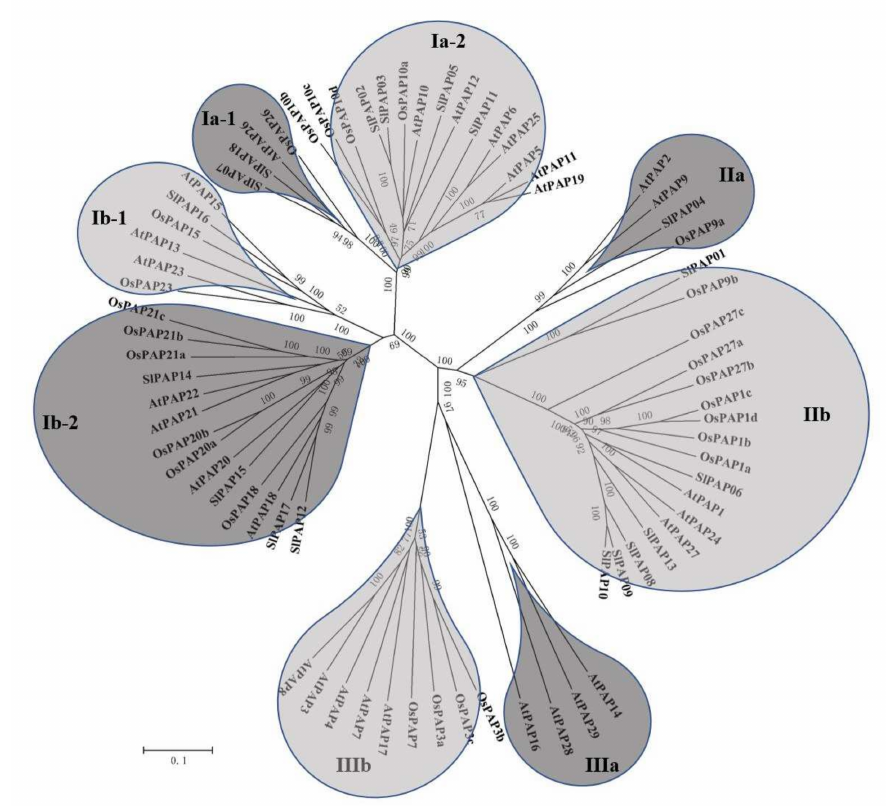
Figure 1. The phylogenetic tree of 73 PAP proteins from tomato, Arabidopsis and rice was constructed with MEGA5.0 software using the neighbor-joining method. Bootstrapping (1000 replicates) was used to evaluate the degree of support for each group in the phylogenetic